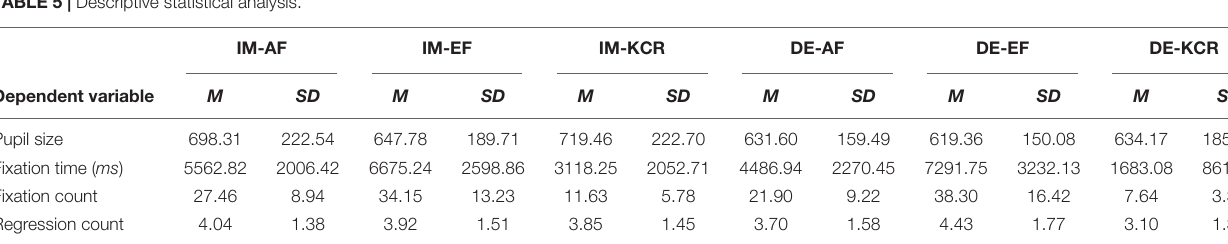
FIGURE 6 | Fixation time of learners on the interest area of the stem under different feedback conditions. TABLE 5 | Descriptive statistical